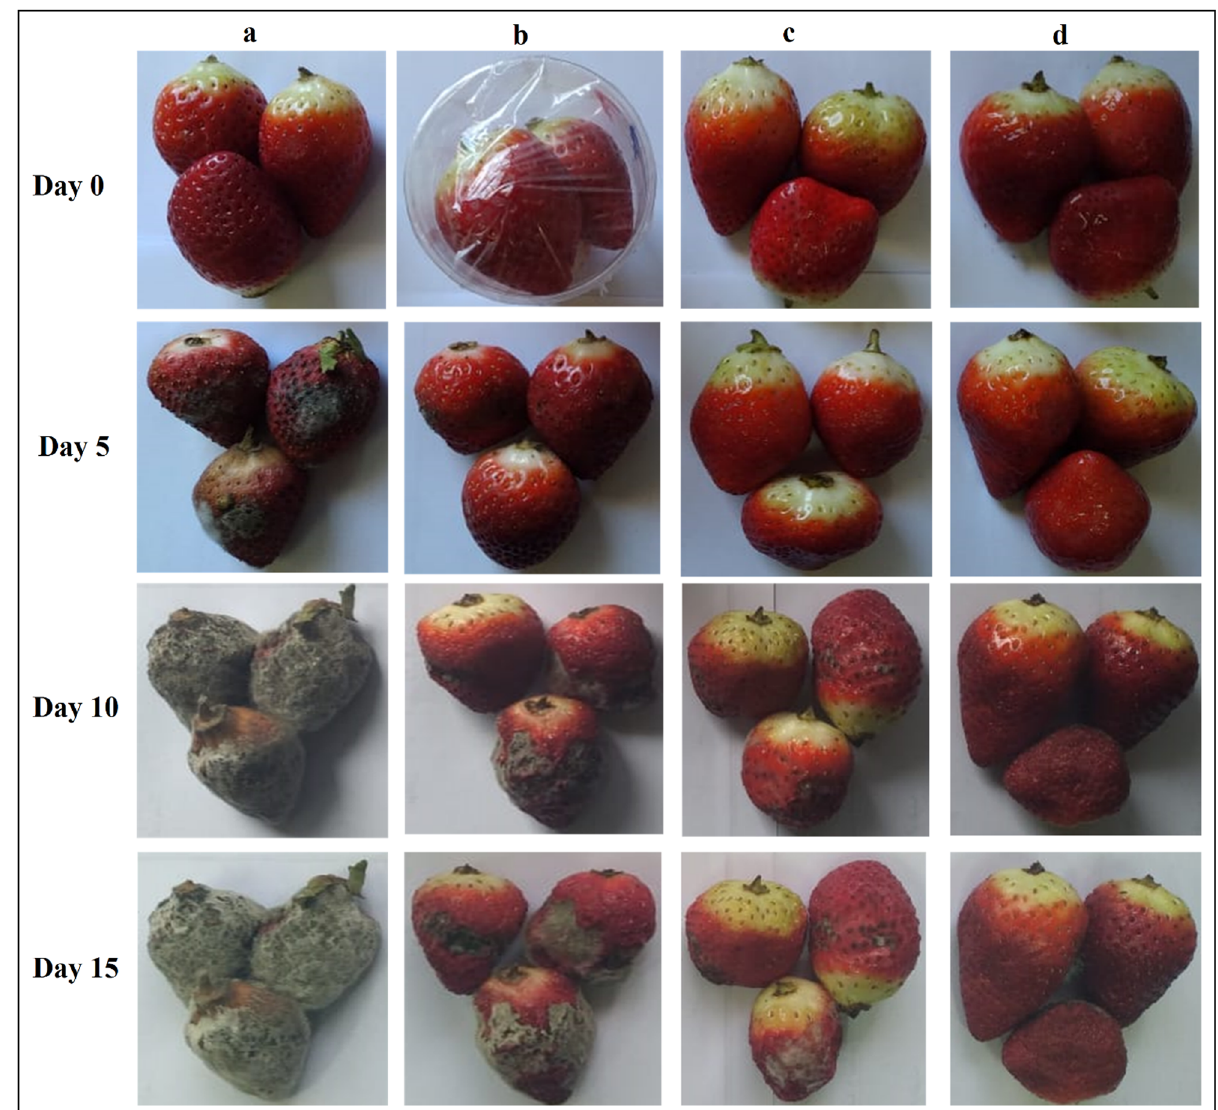
Figure 8: Appearance of untreated strawberries ( control ) ( a ) , packed in a container covered with unirradiated CMC/starch/TiO 2 fi lm ( b ) , surface coated with unirradiated CMC/starch/TiO 2 fi lm ( c ) , and surface coated with irradiated CMC/starch/TiO 2 edible fi lm ( d ) at di ff erent storage